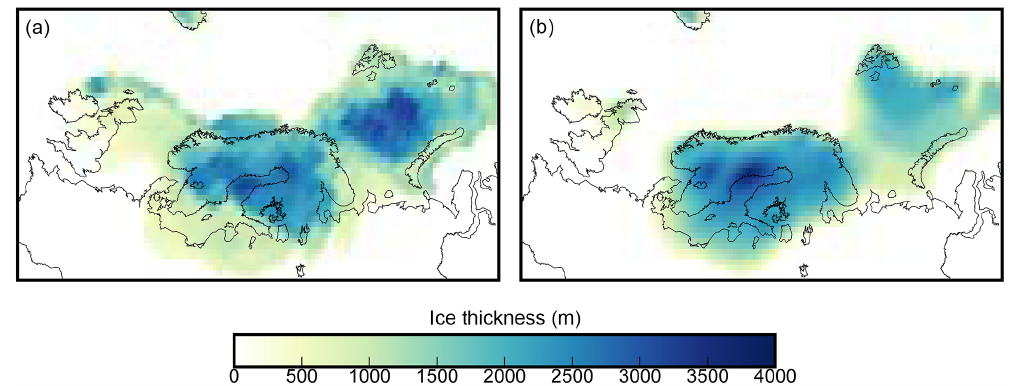
Figure 4. Last Glacial Maximum (LGM) ice cover in Scandinavia, the Barents Sea, and the British Isles from ICE-5G (a) and the ANU model (b)